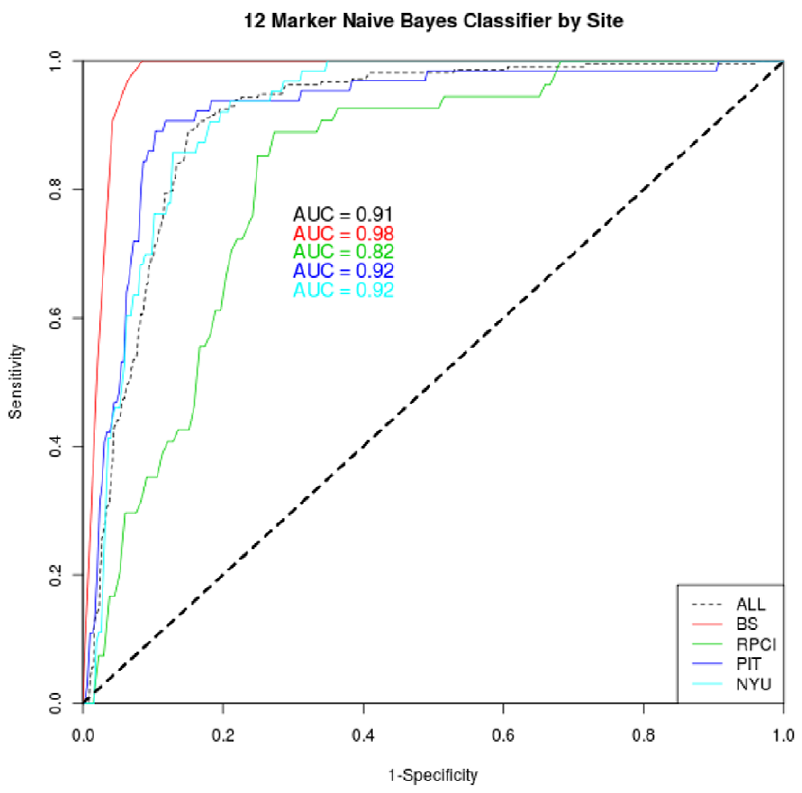
Figure 3. ROC curve performance of the 12-biomarker naı¨ve Bayes NSCLC classifier by study site.